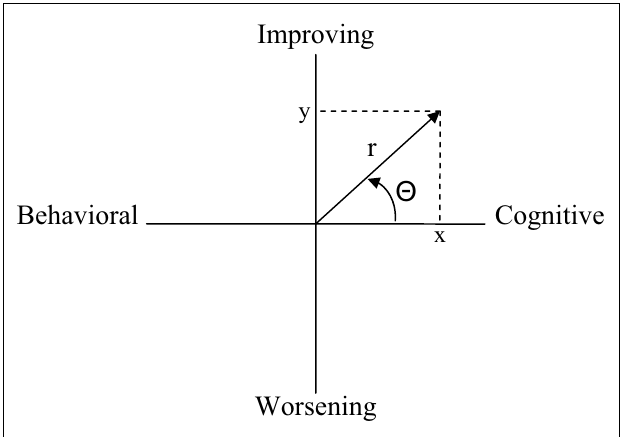
FIGURE 2 | Illustration of Cartesian ( x , y ) and polar ( r , Θ ) coordinates used to calculate spin.